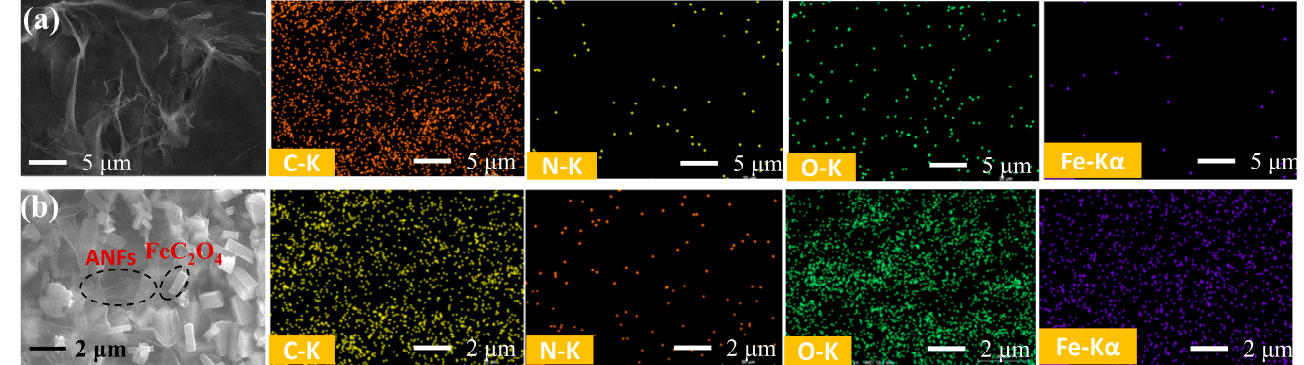
Figure 3. ( a ) SEM images of ANFs membrane, EDS element mapping images of ANFs; ( b ) SEM images of ANFs/FeC 2 O 4 membrane, EDS element mapping images of ANFs/FeC 2 O 4 membrane.